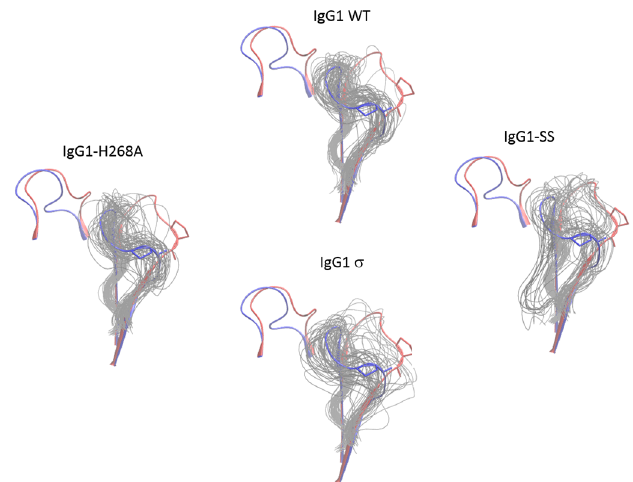
Figure 15. Conformational distribution of the FG loop of chain B of C H 2 domain from molecular dynamics simulations of huIgG1 wild ‐ type and mutants. Each panel shows the flipped ‐ in (blue cartoon) and flipped ‐ out (red cartoon) conformations of the two loops. The flipped ‐ in conformation is from the huIgG1 WT (PDB 3AVE [40]) while the flipped ‐ out conformation is from huIgG4 WT (PDB 4C54 [50]). All simulations were started from the flipped ‐ in conformation of the FG loop. The panels show fifty conformations (gray) sampled at an interval of 2 ns after aligning the molecular dynamics (MD) trajectory on the C α atoms of the non ‐ BC and non ‐ FG residues of the C H 2 domain of chain B in the corresponding crystal structure. Figure S4 shows the conformation of P329 in the above loop conformations. The FG loop of huIgG1 σ and huIgG1 ‐ SS is significantly more flexible than that of huIgG1 WT and huIgG1 ‐ H268A.